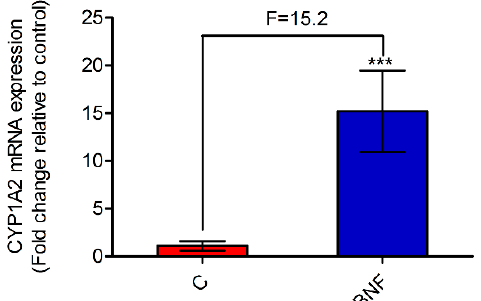
Figure 1. The relative expression of cytochrome P450 1A2 (CYP1A2) mRNA after β -naphthoflavone administration. The mRNA levels were normalized by β -actin expression, and expressed as the fold change relative to control. Data are expressed as mean ± SD, and n = 8 for each group. Unpaired Student’s t -test. *** p < 0.001. C: control group; BNF: β -naphthoflavone treatment group; F: fold change.